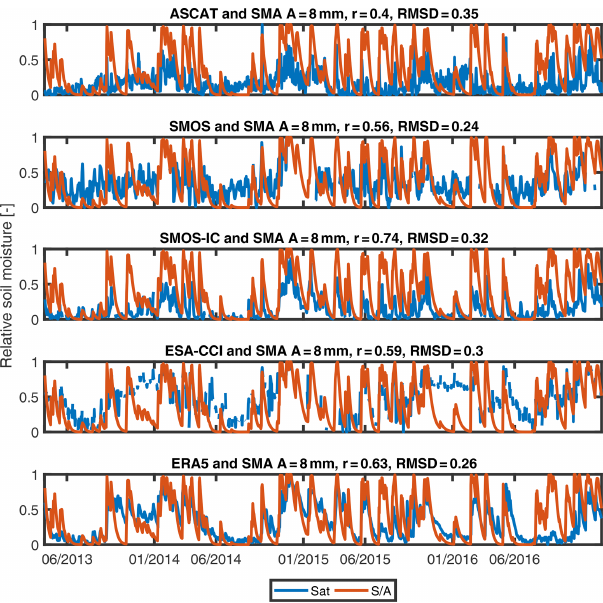
Figure 2. Comparison between measurements of soil moisture (5cm depth) and different products of soil moisture (Rheraya basin).